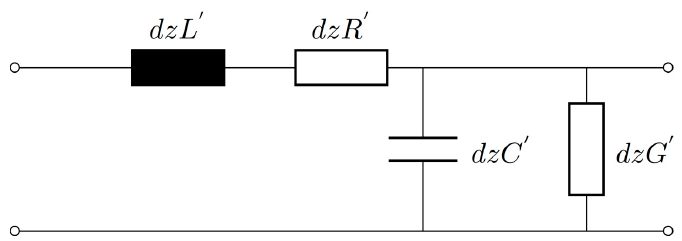
Figure 11. Equivalent network of a TEM-Waveguide.